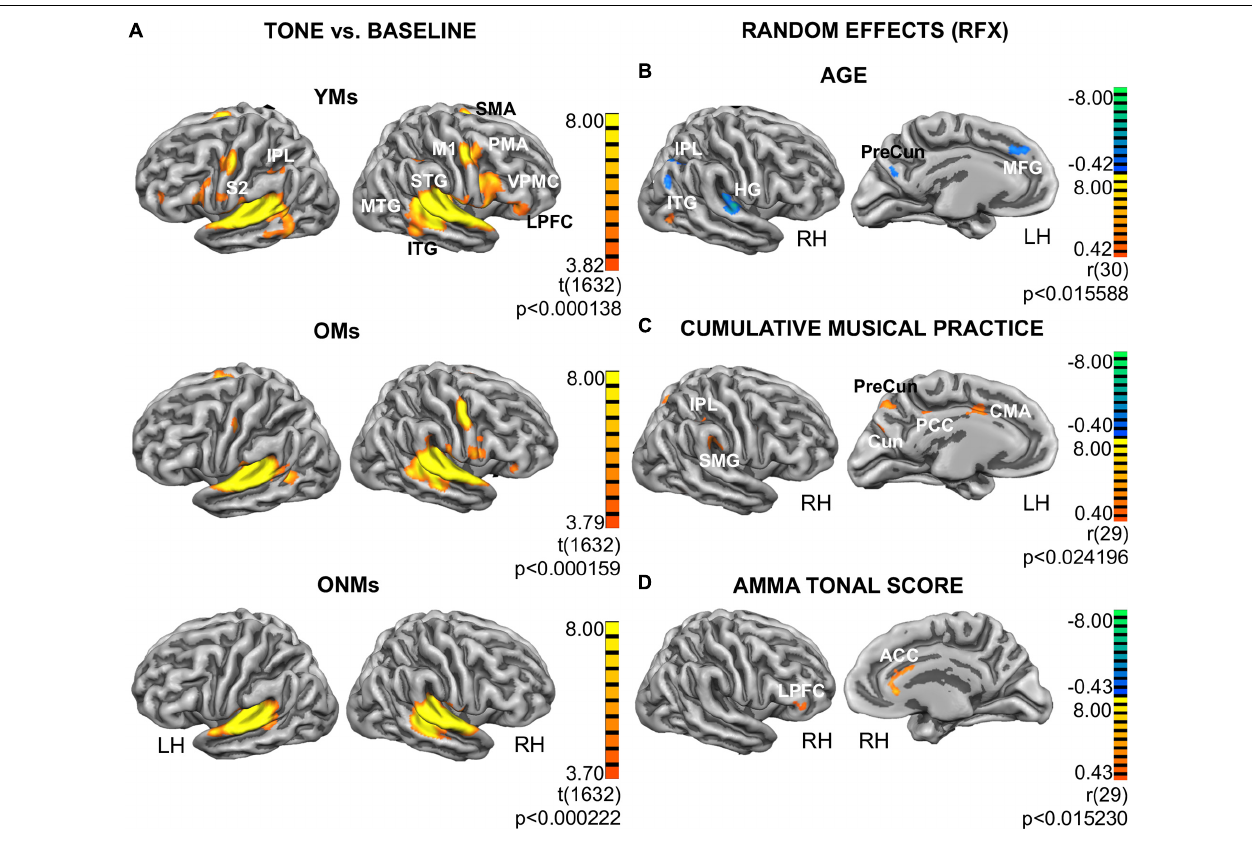
FIGURE 5 | Functional group activations and correlation analyses. (A) Functional results for the attentive tone listening functional MRI (fMRI) task: activation maps from contrast tone listening vs. baseline depicted for each group (YMs, OMs, and ONMs). The results are presented at the threshold FDR ( p < 0.01) and projected on the inflated pial surface of a standard average brain. Red-yellow represents voxels showing increased activity during task (task > baseline). Additional group contrast results can be found in the Supplementary Tables 5–7 . (B–D) Results from the random effects (RFX) group analysis. Only views with significant clusters are presented. Depicted are functional clusters correlating with: (B) age of musicians (YMs and OMs); (C) cumulative musical practice (y*h/w) in the elderly (OMs and ONMs); (D) AMMA tonal score in the elderly (OMs and ONMs). The results have been corrected at cluster level ( p < 0.02). Red-yellow represents positive and blue-green negative correlations, respectively. For more details, see Table 3 . YMs, young musicians; OMs, old musicians; ONMs, old non-musicians; LH/RH, left hemisphere/right hemisphere; RFX, random effects group analysis; AMMA, Advanced Measures of Music Audiation test; M1, primary motor cortex; SMA, supplementary motor area; PMA, premotor area; S2, secondary somatosensory cortex; IPL, inferior parietal lobule; SMG, supramarginal gyrus; HG, Heschl’s gyrus; STG, superior temporal gyrus; MTG, middle temporal gyrus; ITG, inferior temporal gyrus; VPMC, ventral premotor cortex; LPFC, lateral prefrontal cortex; MFG, middle frontal gyrus; PreCun, Precuneus; Cun, Cuneus; ACC, anterior cingulate cortex; PCC, posterior cingulate cortex; CMA, cingulate motor